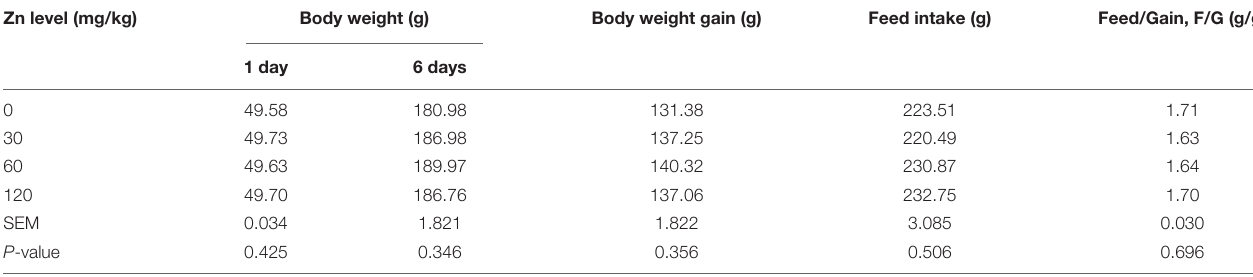
TABLE 4 | Effect of dietary Zn–Met levels on growth performance of duck during 1–6 days.